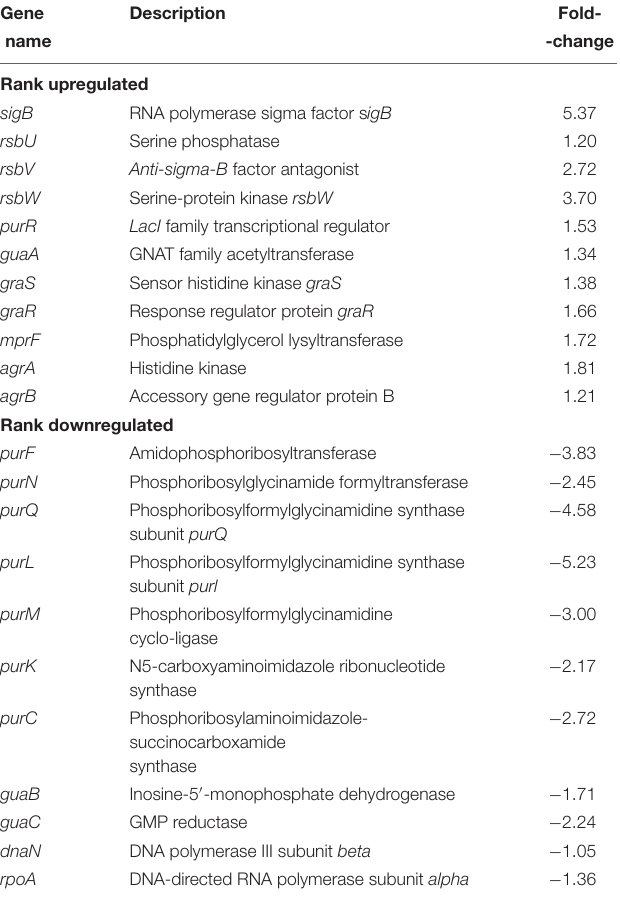
TABLE 3 | The fold changes determined by RNA-seq of some sigB -related genes. Gene Fold-